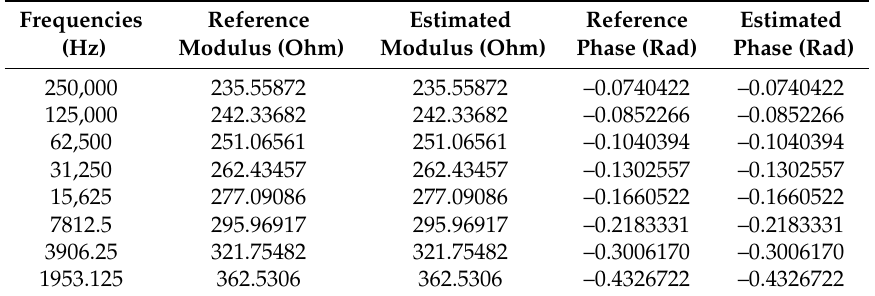
Table 2. Results of the numerical simulation performed with Scilab compared with reference values. Frequencies